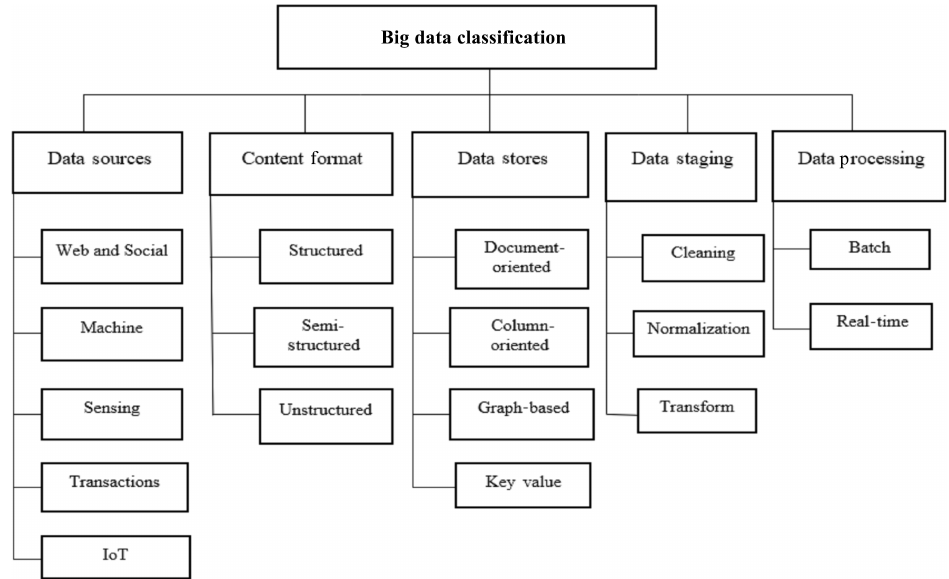
Fig. 2 Types of big